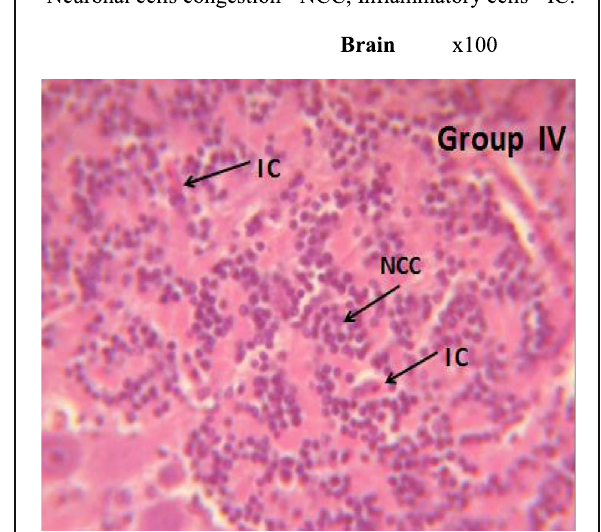
Fig. 8 Photomicrograph of the brain from a bird in group IV at the end of 12 weeks of direct exposure to 3 mg CN kg − 1 body weight.